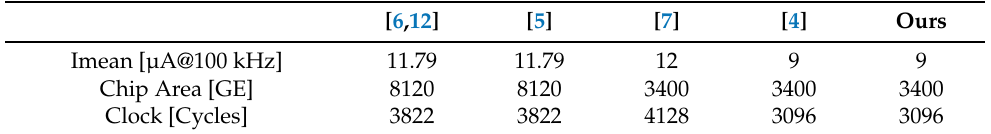
Table 5. Efficiency